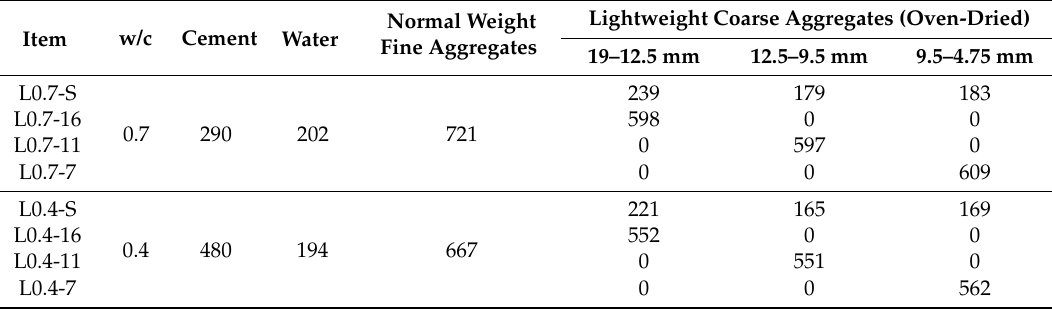
Table 3. Mix proportions of lightweight aggregate concrete (LWAC) (kg/m 3 ).